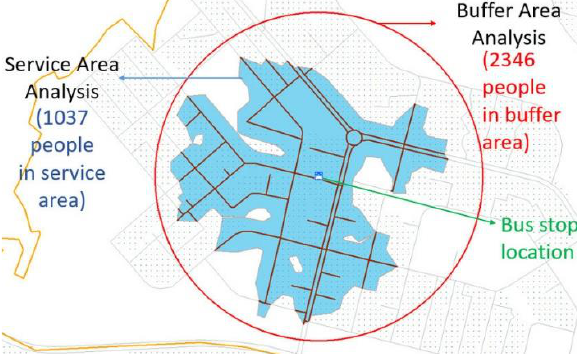
Figure 2. Comparison of Buffer and Service Area Analysis (Aslan, H., Kocaman, H., 2018).